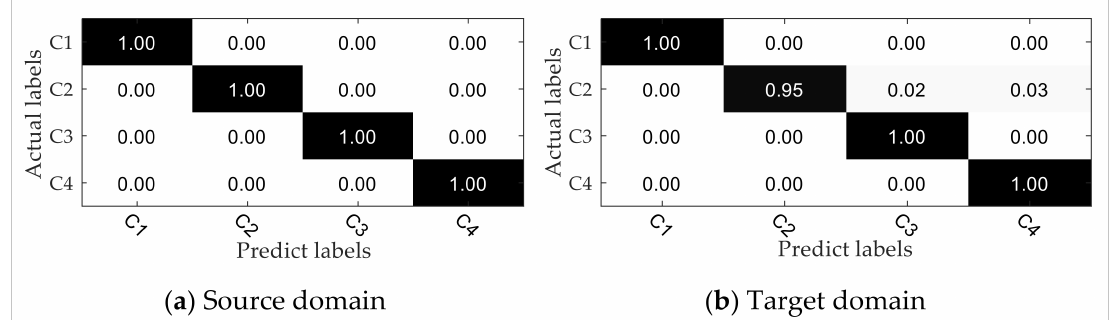
Figure 12. The confusion matrix of the DAN-DAM model in two domains for private